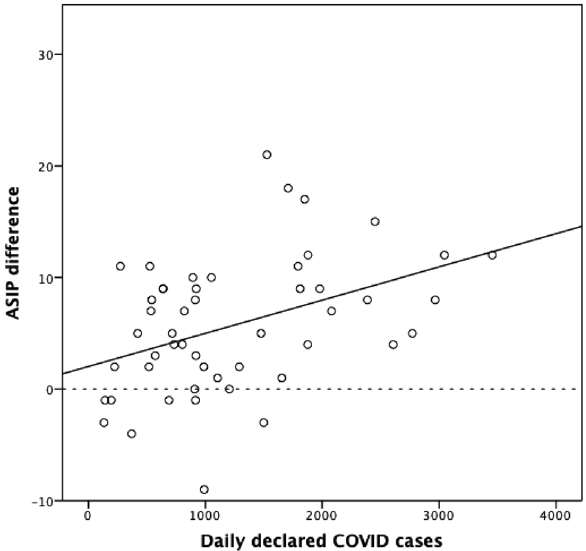
Figure 2. Dispersion diagram of daily difference in number of ASIP within 2019 and 2020 and the number of COVID-19 cases (Community of Madrid data only). ASIP appendicitis, cholecystitis, diverticulitis and perianal abscesses, COVID-19 coronavirus disease 2019.